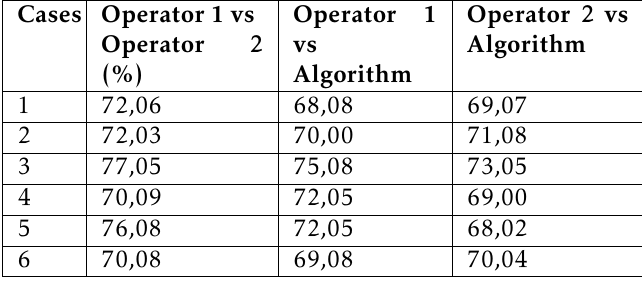
Table 1. Dice similarity values obtained by the algorithm for the evaluated